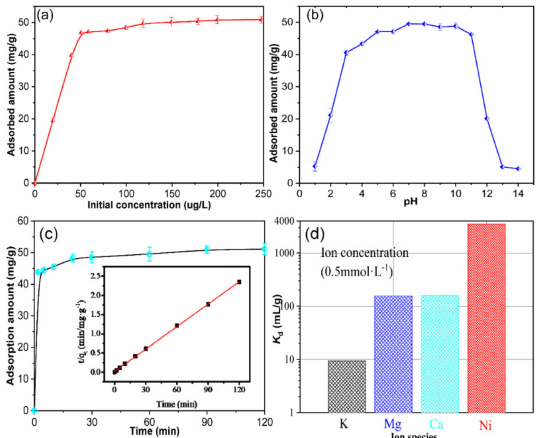
Figure 9. The bath experiment results. ( a ) The influence of the initial concentration on the adsorption of Ni ions; ( b ) The effect of pH on the adsorption of Ni ions; ( c ) The influence of the contact time on the adsorption of Ni ions; ( d ) The selective adsorption property of Ni from the multi-component aqueoussolution by the